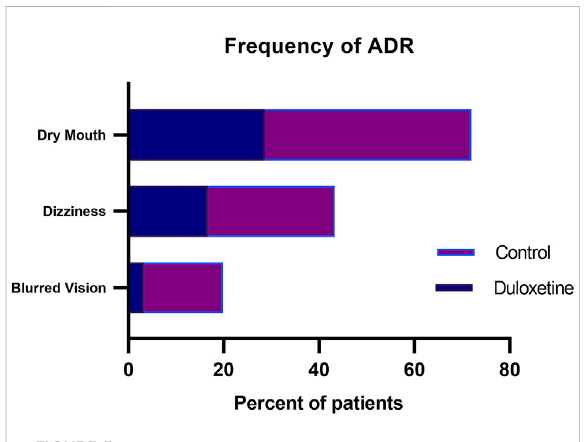
FIGURE 5 Incidence of the common adverse effects in the two